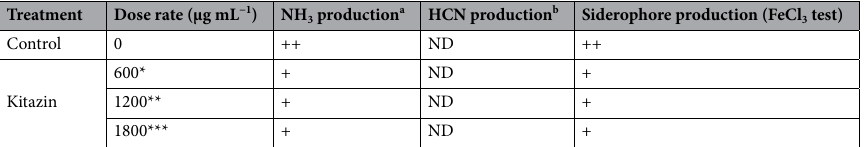
Table 1. Ammonia, HCN and siderophore production by M. ciceri BRM5 under kitazin stressed condition. In this table, *, ** and *** represents the 1 ×, 2 × and 3 × concentrations of kitazin, respectively. a Ammonia. b HCN production. ++ and ND indicate ‘positive reaction’ and ‘not detected’,